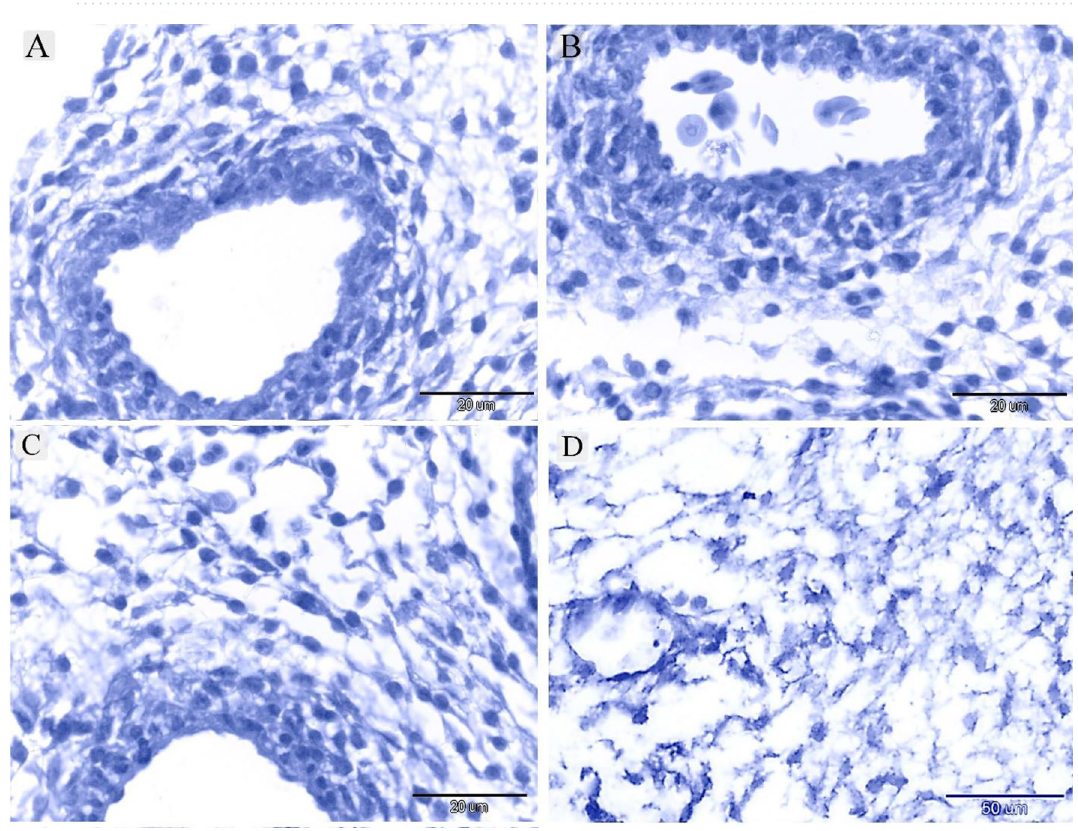
Figure 9. Scanned samples of the neck skin of quail embryos at day 8. ( A , B , D – F ) TCs (blue colored) surrounded the blood vessels (bv). Note that the TPs formed a 3D network, podoms (yellow circles). ( C ) TCs (blue colored) surrounded the blood sinusoids (bs).